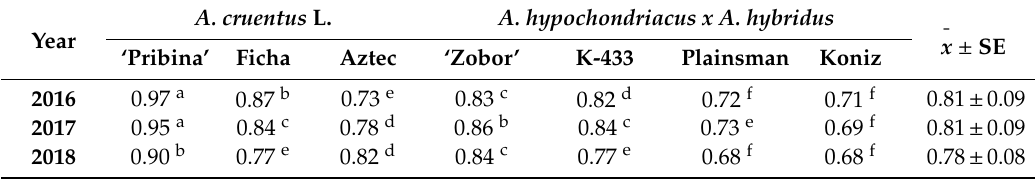
Table 1. The 1000-seed weight of investigated amaranth samples tested during three consecutive growing seasons.